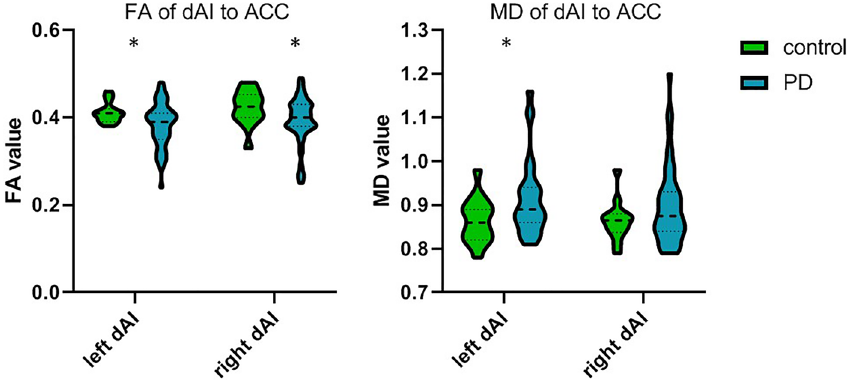
Figure 2. Group differences in FA and MD of dAI to ACC tract. PD patients showed lower FA in dAI to ACC tracts than controls, and higher MD in left dAI to ACC tract. FA = fractional anisotrophy; MD = mean diffusivity; vAI = ventral anterior insula; dAI = dorsal anterior insula. * p <